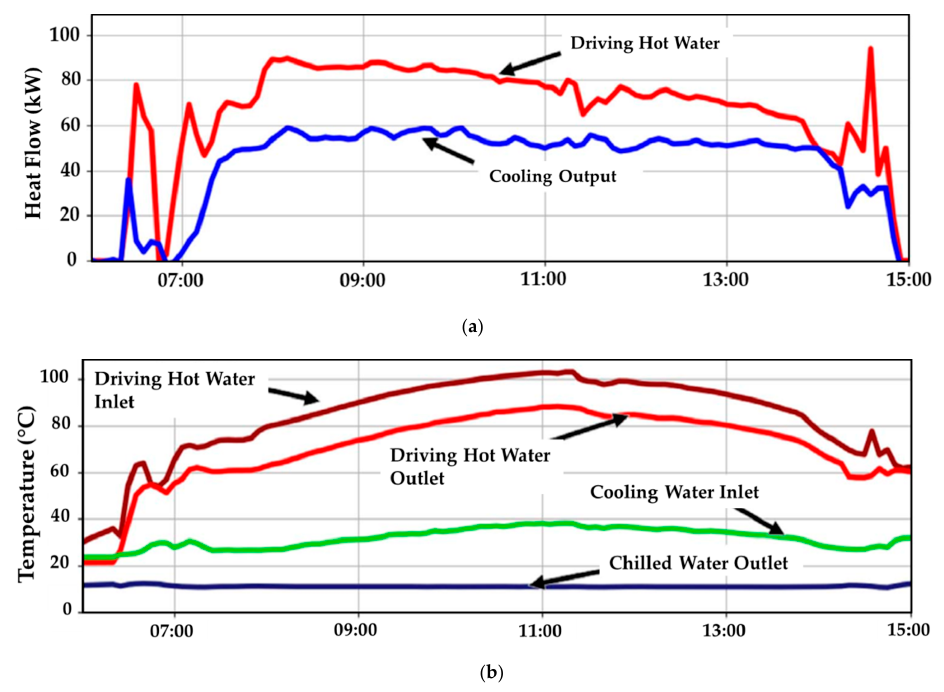
Figure 4. The new absorption heat pump machine, new ‐ AHP, operating as a chiller for solar space cooling in extreme ambient conditions in Jordan [24]. (a) Driving heat input and cooling capacity; (b) Temperature of the external heat carrier streams.